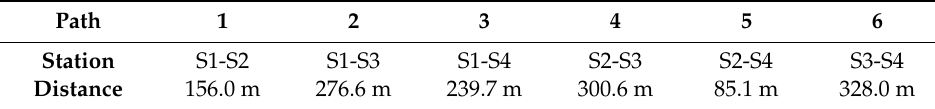
Table 1. Station-to-Station